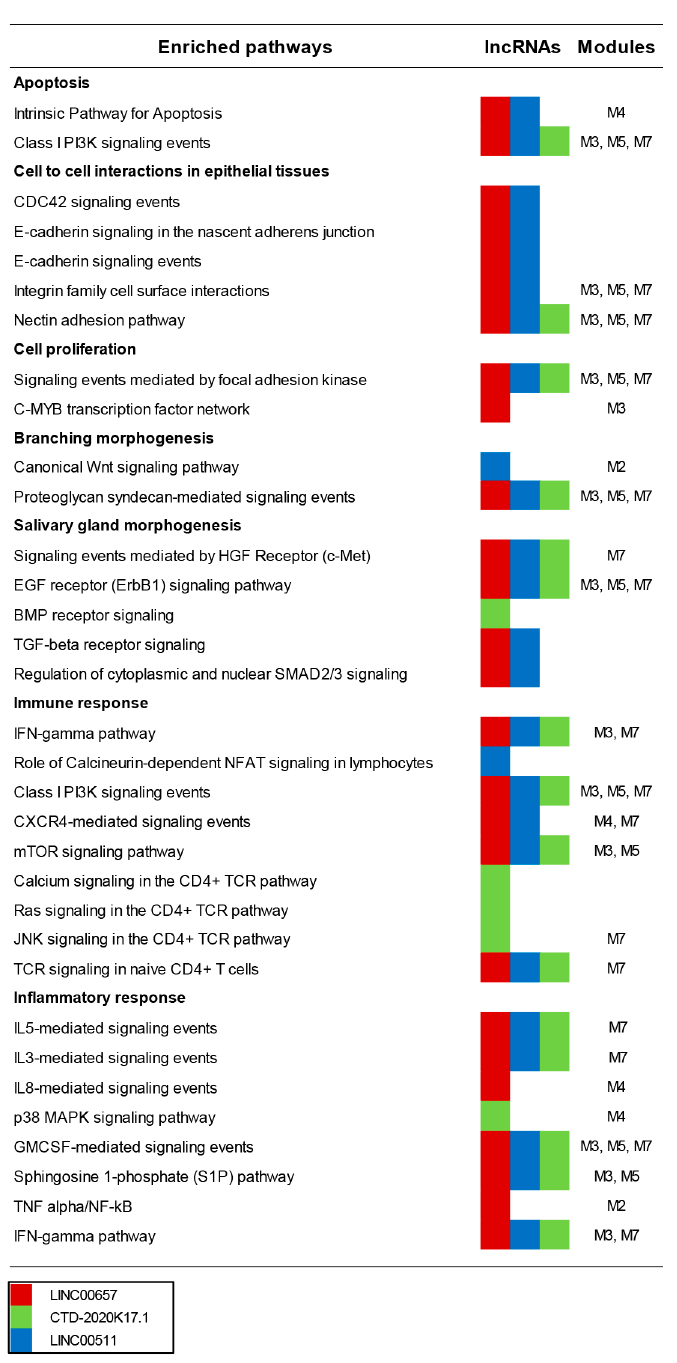
Figure 3. Meaningful pathways enriched in modulated genes targeted by the three selected lncRNAs. Colored squares indicate pathways enriched in genes targeted by the three lncRNAs: CTD-2020K17.1 (green squares); LINC00657 (red squares); LINC00511 (blue squares). The modules with the same enriched pathways are shown.